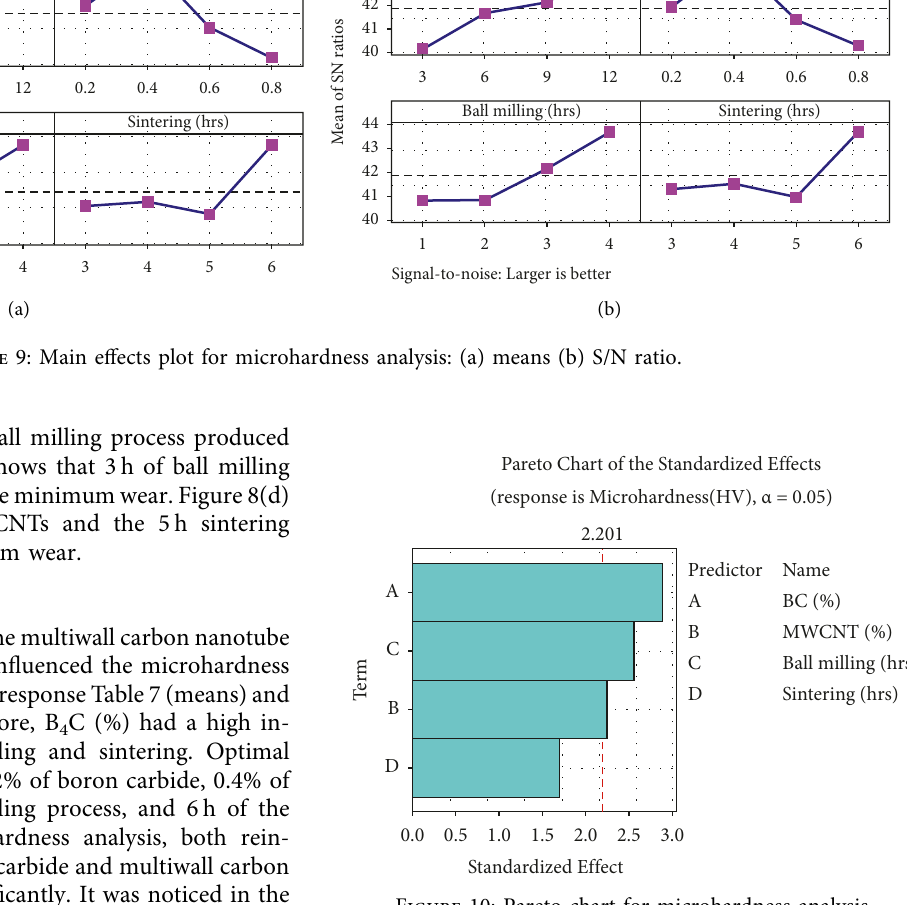
Figure 10: Pareto chart for microhardness